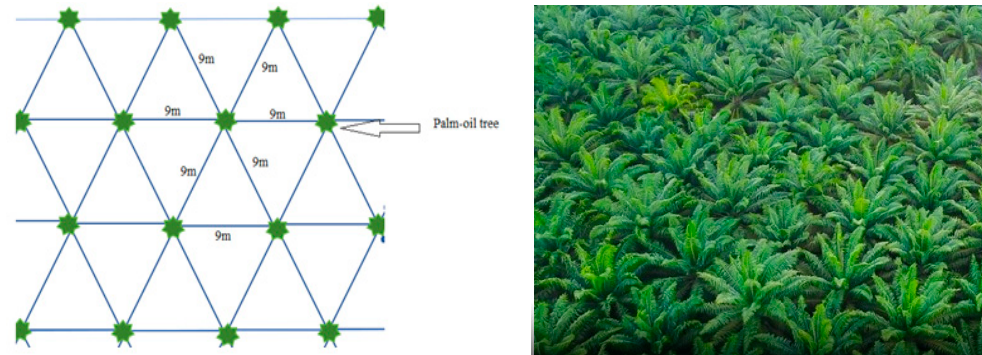
Figure 1. Multi-wall prediction model.